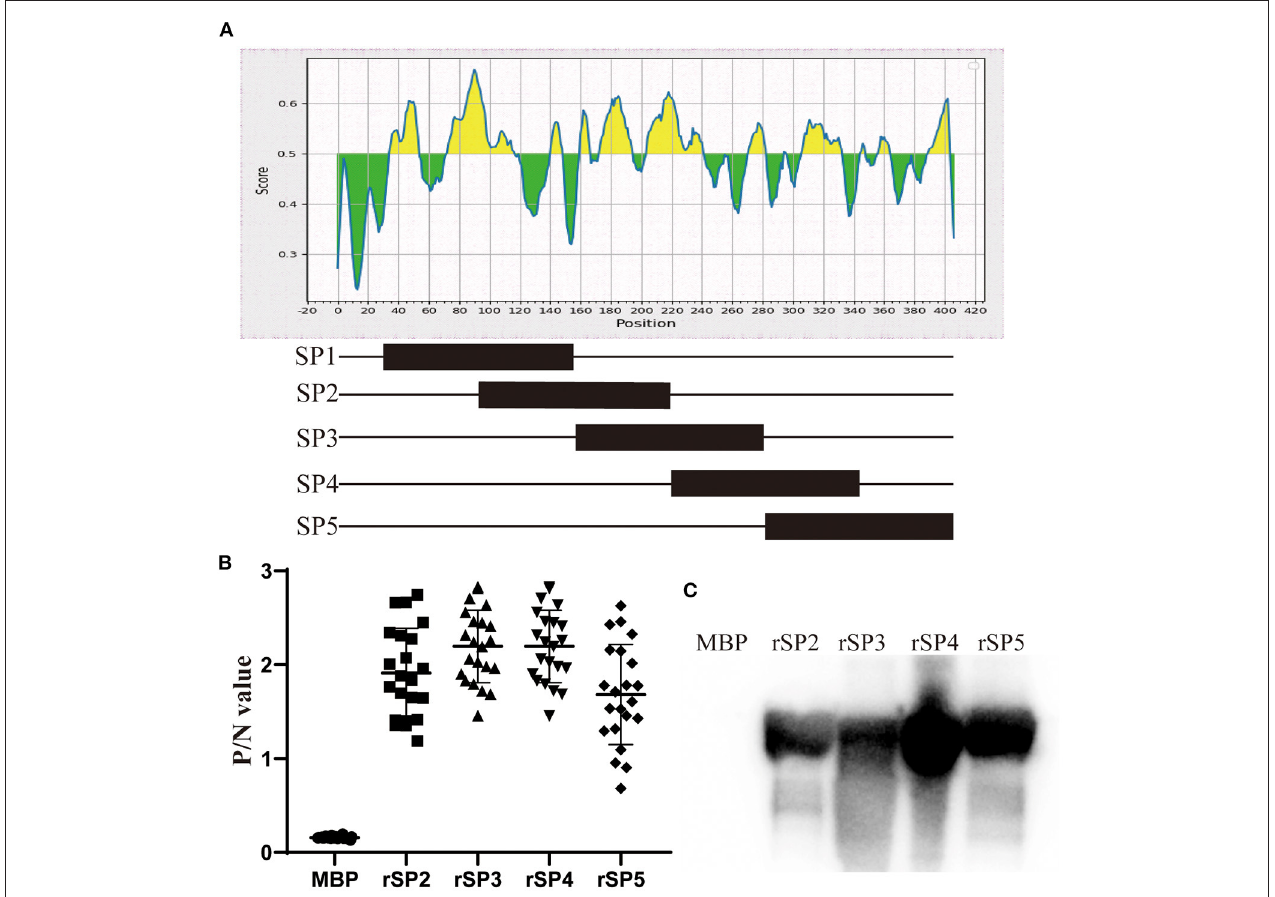
FIGURE 5 | Immune epitope analysis of P35. (A) Schematic diagram of truncated expression of P35. Excluding the signal peptide region, P35 protein was divided into five segments, and half the sequence repeats are between adjacent segments. (B) ELISAs were developed by coating plates with rSP2, rSP3, rSP4, and rSP5 segments and incubated with chicken serum against Mycoplasma synoviae (MS) as primary antibody, and MBP was coated as the negative control. (C) Western blotting assay of rSP2, rSP3, rSP4, and rSP5 segments reacted with chicken serum against MS. MBP was used as the negative